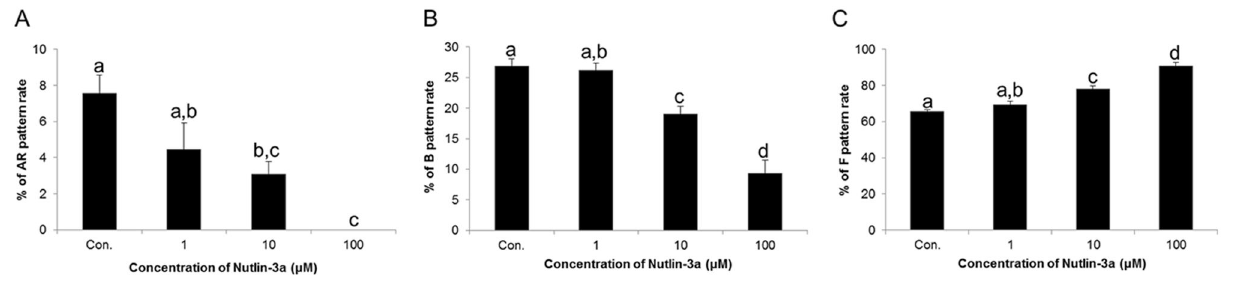
Figure 1. Effects of nutlin-3a on sperm capacitation status in vitro . (A) Changes in acrosome reacted (AR pattern) spermatozoa in controls and nutlin-3a-treated samples. (B) Changes in capacitated (B pattern) spermatozoa in controls and nutlin-3a-treatedsamples. (C) Changes in non-capacitated (F pattern) spermatozoa in controls and nutlin-3a-treated samples. Data are expressed as the mean ± SEM, n=5. Values with different superscripts ( a,b,c,d ) indicate significant differences between control and treatment groups on one-way ANOVA ( p